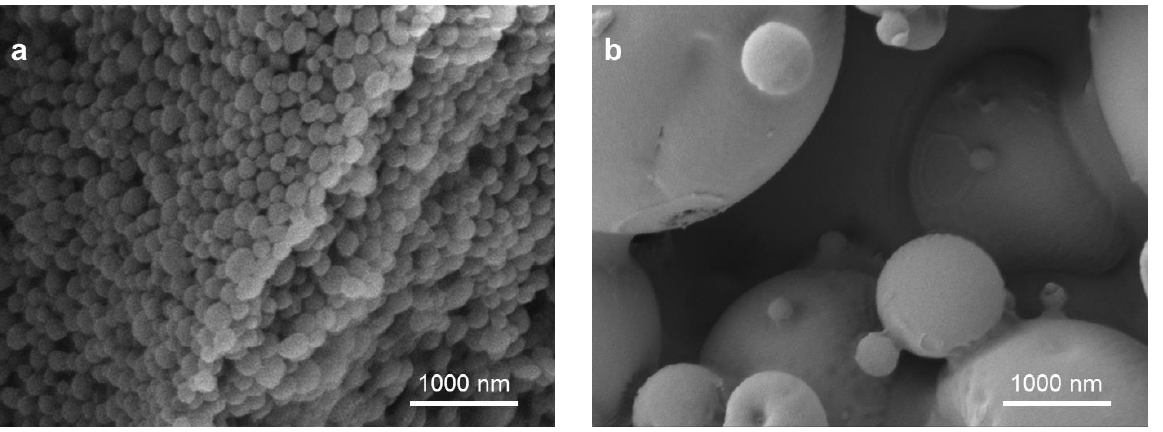
Figure 3. Scanning electron microscopic pictures of ( a ) nano sized and ( b ) micron sized PLGA Scanning electron microscopic pictures of ( a ) nano sized and ( b ) micron particles. sized PLGA